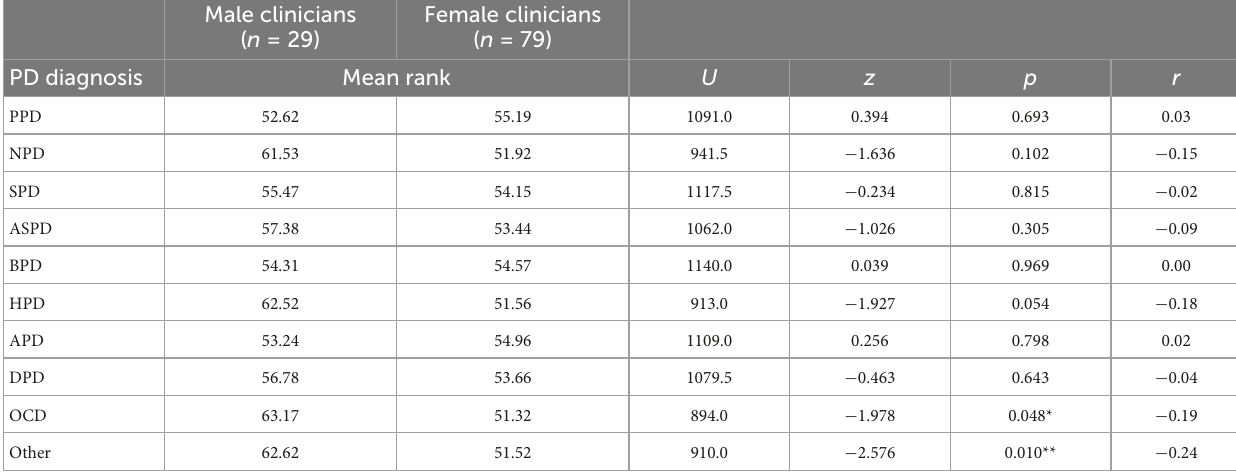
TABLE 5 Mann–Whitney comparisons for participant gender in vulnerable narcissism condition. Male clinicians Female clinicians ( n = 29) ( n = 79) PD diagnosis